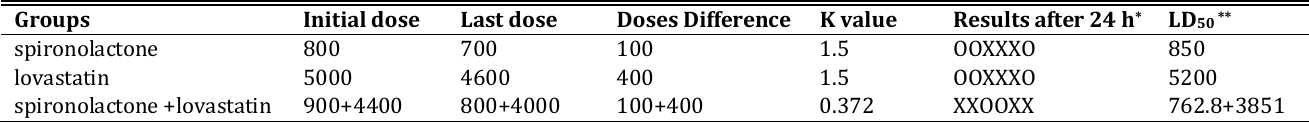
Table 4 . Determination of LD50 for spironolactone, lovastatin and their interaction in study Groups